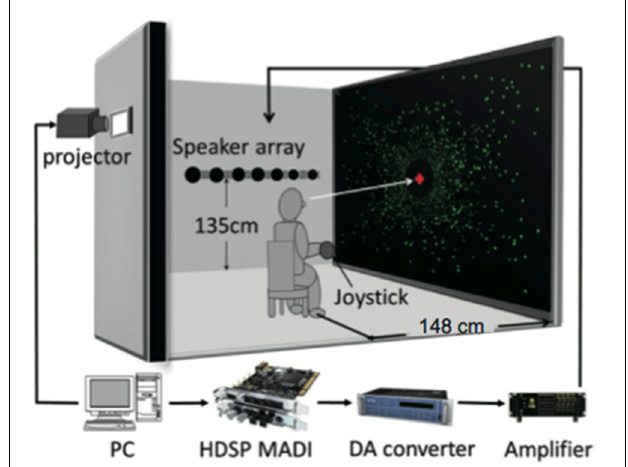
FIGURE 1 | Schematic diagram of experimental setup. Large-field visual motion was presented to induce self-motion perception in either a forward or a backward direction. During participants’ experience of self-motion, a short noise burst was delivered from one of the loudspeakers aligned parallel to the motion direction along a wall to the left of the